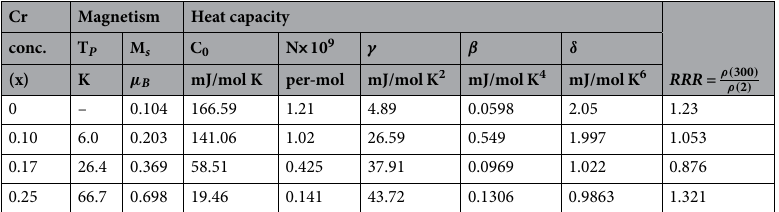
Table 2. Various fitting parameters obtained from the analysis of magnetization, heat capacity data and the measured value of residual resistivity ratio (RRR).